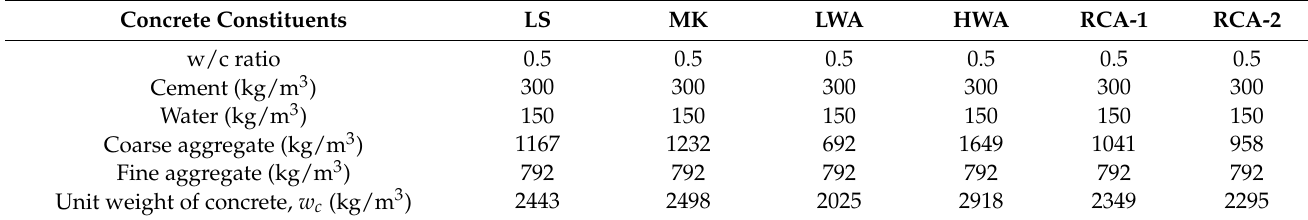
Table 2. Concrete mixture design of Mix 1.